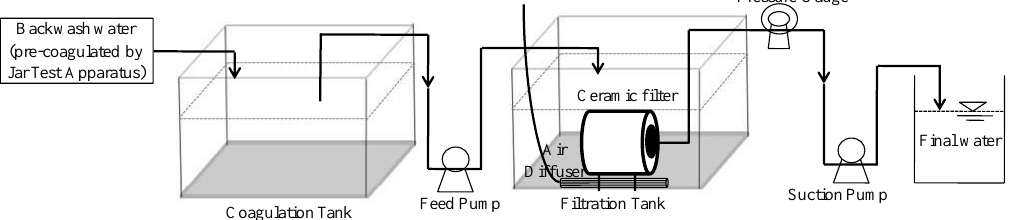
Figure 2. Schematic diagram of filtration experiments.